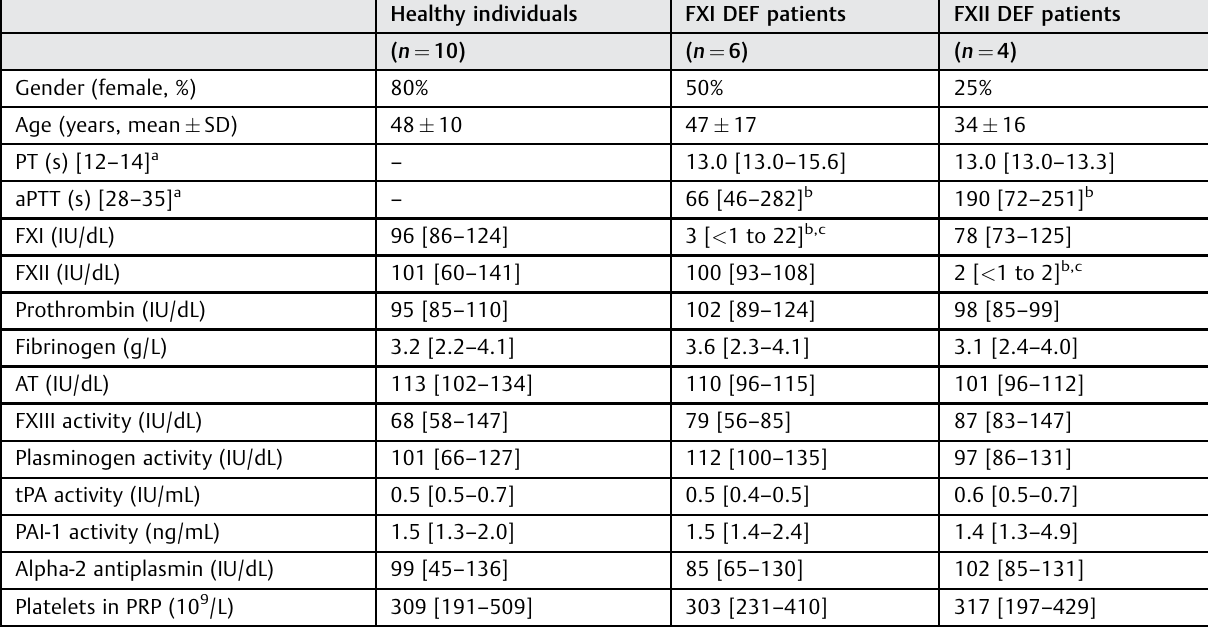
Table 1 General characteristics of the study population Healthy individuals FXI DEF patients FXII DEF